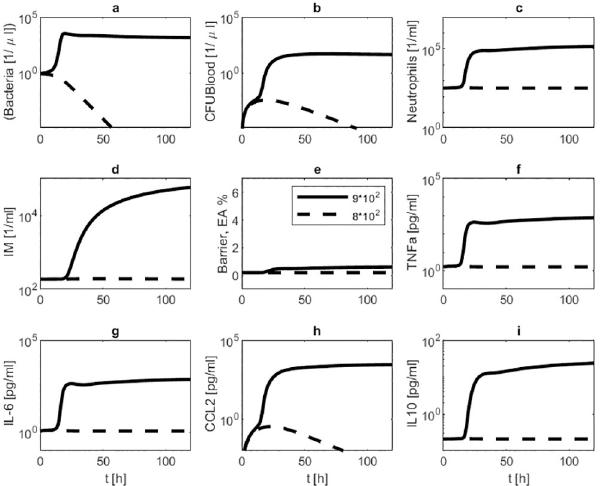
Fig 3. Model behaviour in dependence on initial bacterial load. We present simulation results of infections with 8 � 10 2 (dotted line) respectively 9 � 10 2 (solid line) seeded Streptococcus pneumoniae without treatment. Time series of pneumococcal population in BAL (a) and blood (b), neutrophils in BAL (c), inflammatory macrophages in BAL (d), barrier function (e), TNF- α in BALF (f), IL-6 in BALF (g), CCL2 in BALF (h) and IL-10 in BALF (i) are displayed. The lower infectious dose results in cure while the larger infectious dose leads to disseminated disease.